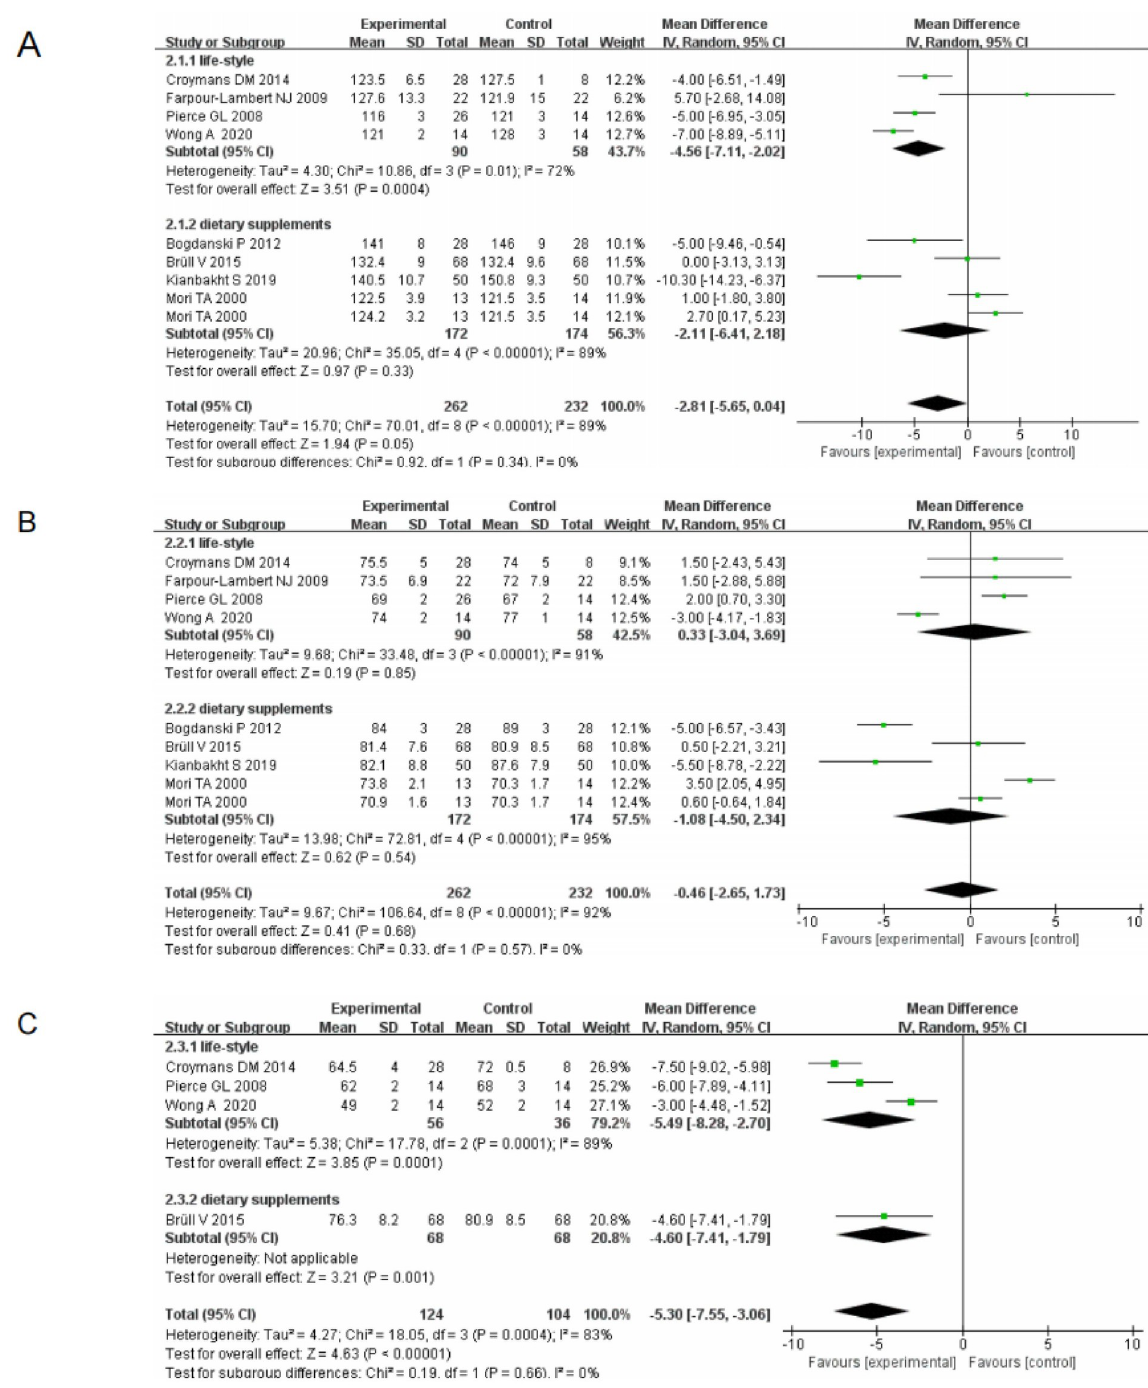
Fig 3. Forest plot of primary outcome indicators(I) (A) SBP Forest plot of primary outcome indicators (B) DBP Forest plot of primary outcome indicators (C) Heart rate Forest plot of primary outcome indicators.